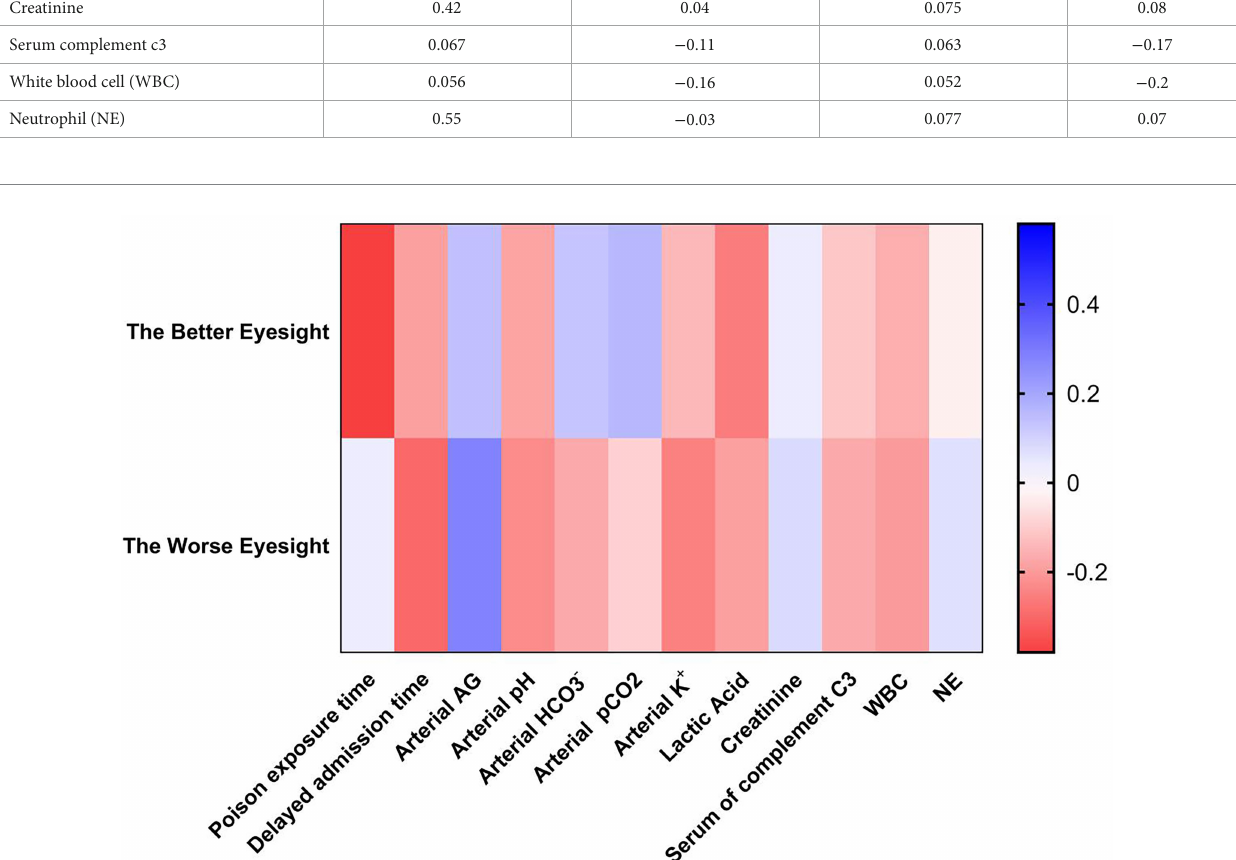
FIGURE 5 Heatmap of vision prognosis and risk analysis of inhalational methanol poisoning. The better eyesight was referred to as the better vision of the patient’s binocular vision. The worse eyesight was referred to as the worse vision of the patient’s binocular vision. AG, anion gap; WBC, white blood cell; NE, neutrophil.